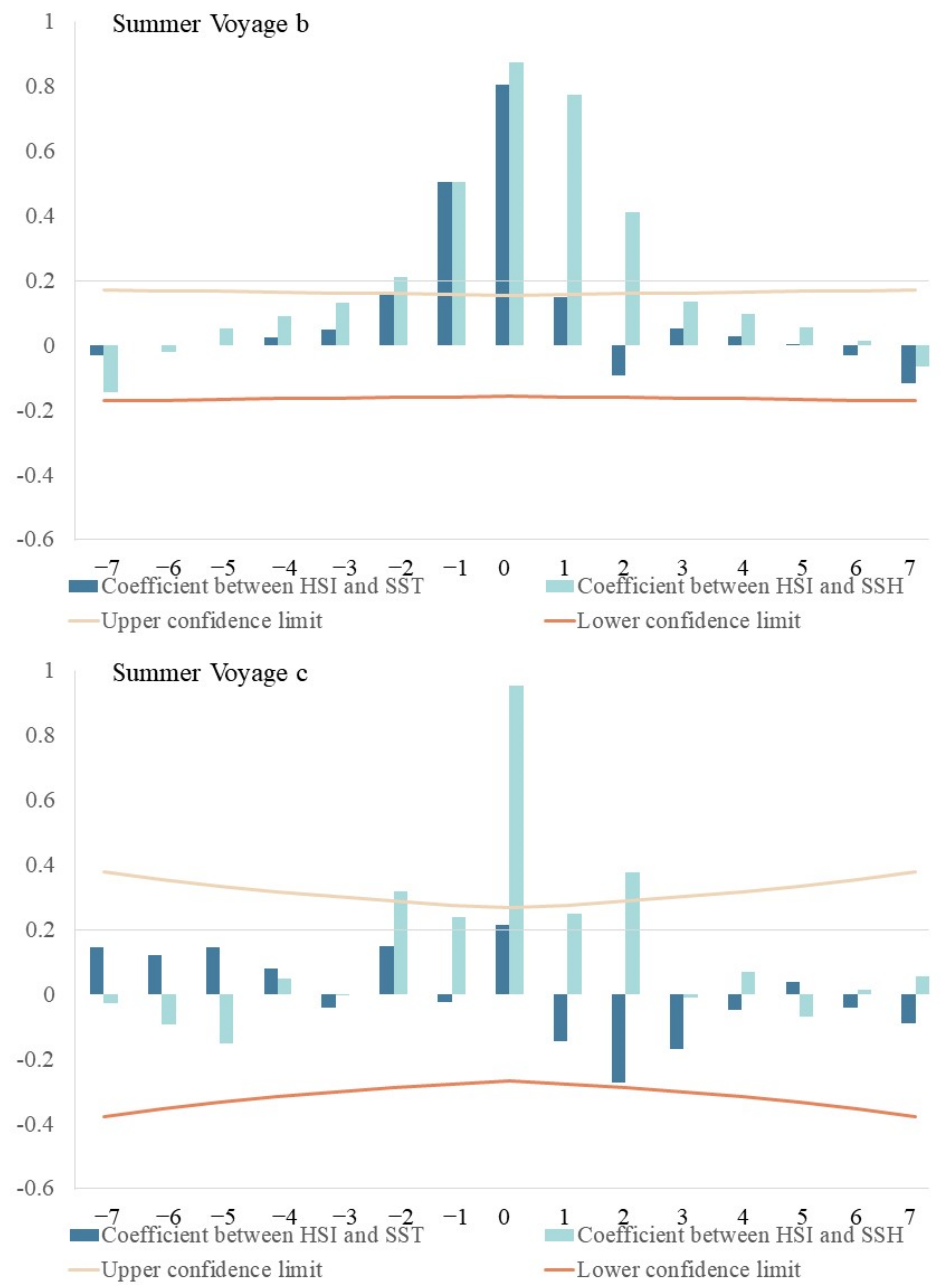
Figure 6. Cross ‐ correlation coefficients between average HSI and environmental factors for Auxis thazard in the South China Sea. Spring Voyage a, b, c, which are voyages 2, 3, and 5 in Table 1, Summer Voyage a, b, c, which are voyages 4, 6, and 8 in Table